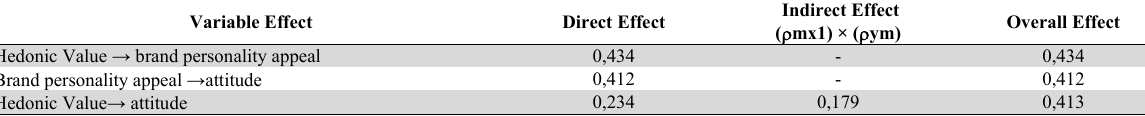
Direct and Indirect Effect as well as Overall Effect of Hedonic Value (X 1 ), Brand personality appeal (X 2 ), and attitude (Y 1